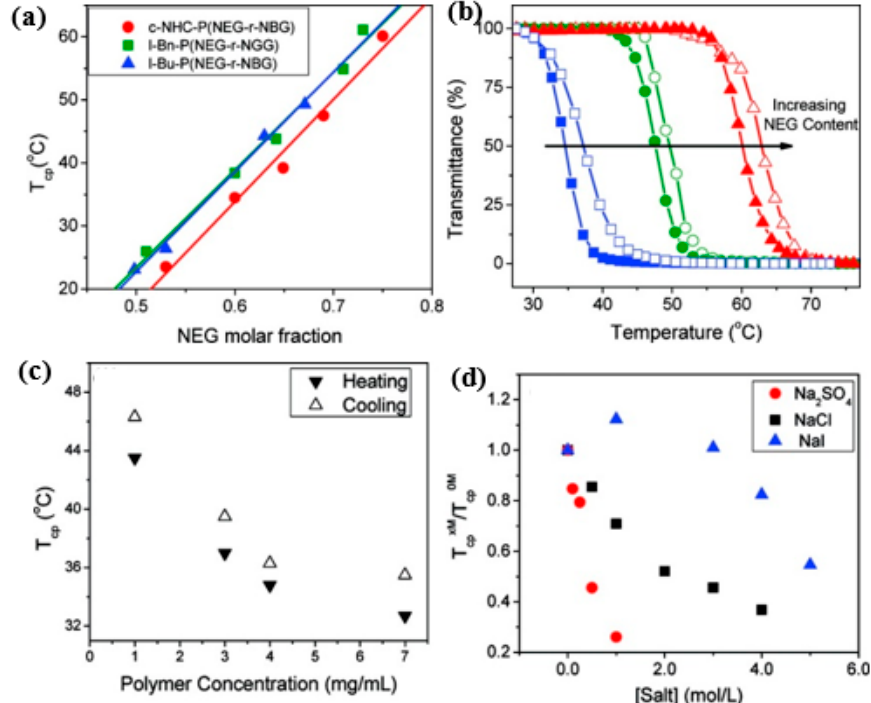
Figure 4. ( a ) Representative plots of transmittance at λ = 450 nm vs. temperature for the selected aqueous solutions of cyclic copolypeptoids c -NHC-P(NEG 70 - r -NBG 47 ) (blue); c -NHC-P(NEG 65 - r -NBG 30 ) (green); c -NHC-P(NEG 101 - r -NBG 34 ) (red) (polymer concentration = 1.0 mg / mL; heating and cooling cycles are symbolized by the filled and unfilled symbols, respectively) ( b ) Plots of cloud point temperature ( T cp ) versus the molar fraction of NEG segment in the cyclic and linear P(NEG- r -NBG) random copolymers bearing different end groups and their respective linearly fit curves, c -NHC-P(NEG 70 - r -NBG 47 ) (blue); c -NHC-P(NEG 65 - r -NBG 30 ) (green); c -NHC-P(NEG 101 - r -NBG 34 ) (red). ( c ) Plot of T cp s of c -NHC-P(NEG 55 - r -NBG 26 ) vs. the polymer concentration in water; ( d ) plot of T cp s of c -NHC-P(NEG 62 - r -NBG 23 ) at various salt concentrations ( T cpxM ) relative to that with no salt ( T cp0M ) vs. the salt concentration in water. Reprinted with permission from [55] . Copyright 2012, American Chemical Society.